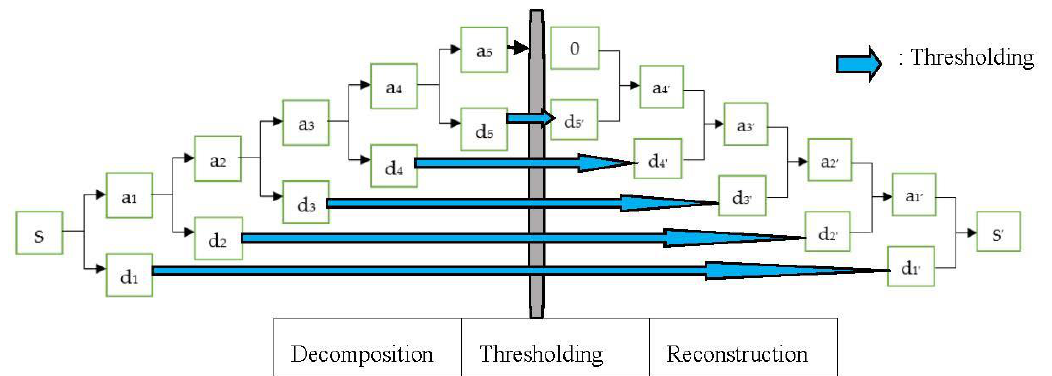
Figure 4. Noise reduction scheme of the wavelet transform (WT).